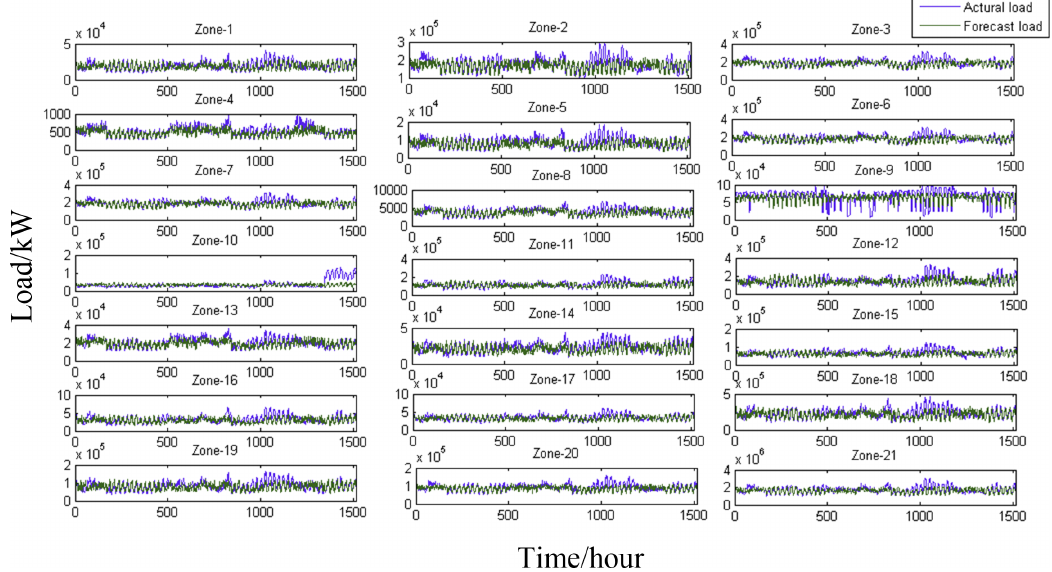
Fig 5. Actual and backcasted/forecasted loads for the 20 zones and the total load. The sub-figures (labelled Zone-1 to Zone-21) represent Zone 1 to Zone 20 and the total load measured in kW. The actual power load and the modelled load (including the backcasted load for the eight missing weeks and the forecasted load for one week) are shown, where blue indicates the actual load and green indicates the modelled load. The same colours and symbol codes are applied to each zone and to the total load (denoted by Zone